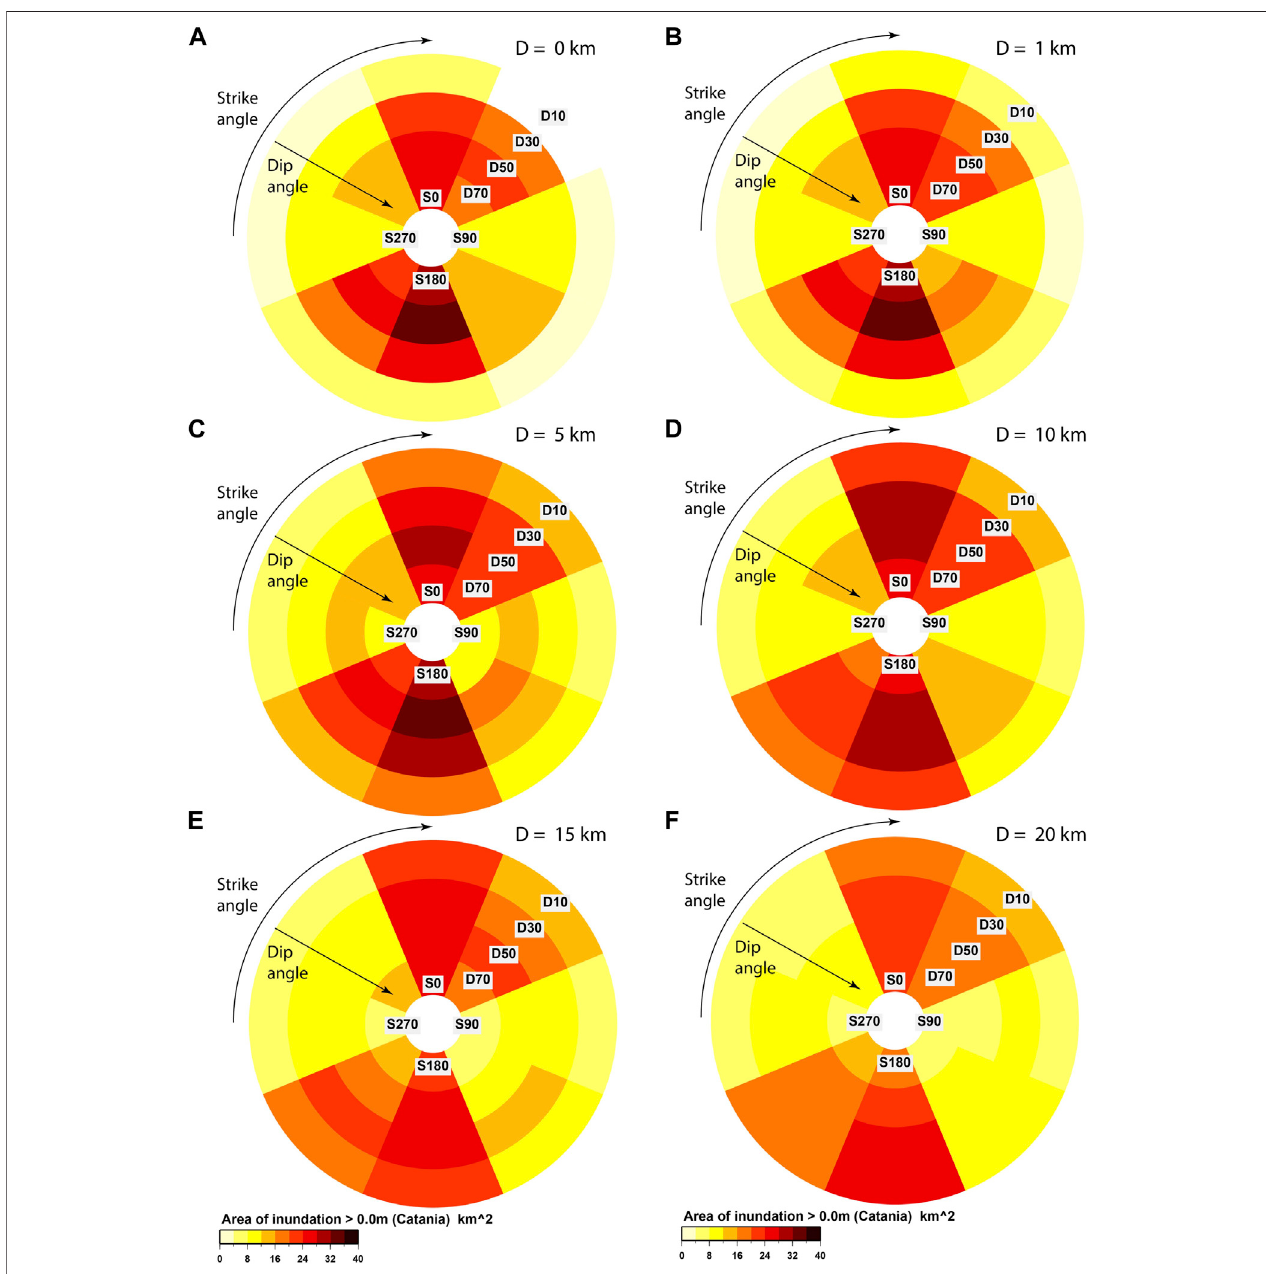
FIGURE12| Area ofinundation inthebay ofCataniaasafunctionofstrike, dip,and depth fortsunamis with theearthquakesources with rake (cid:1) 90 o .Panels (A – F) indicate respectively inundation resulting from earthquakes with depths 0, 1, 5, 10, 15, and 20 km.